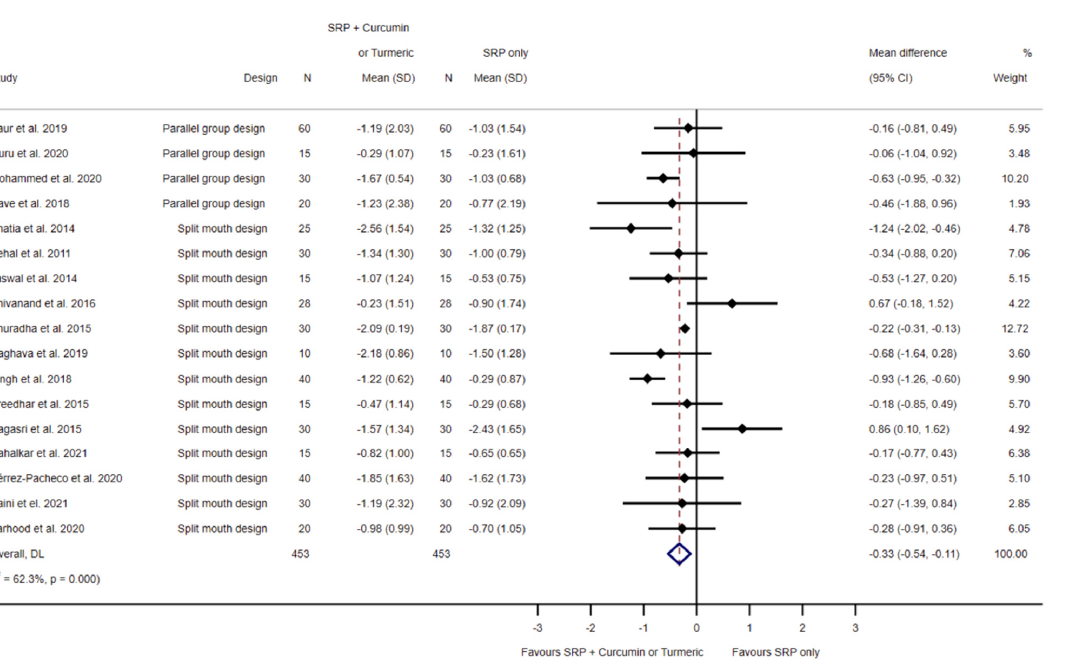
Figure 3. Forest plot for the comparison of SRP to SRP and local curcumin/turmeric application